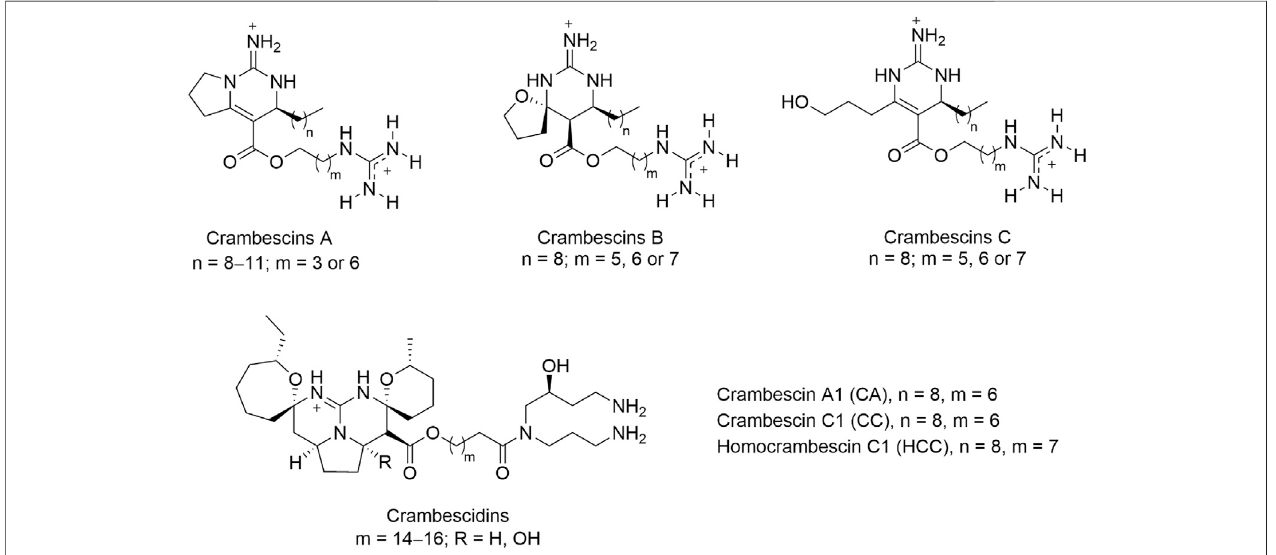
FIGURE 1 | General chemical structures of guanidine alkaloids from the marine sponge crambe crambe, crambescins (A – C) and crambescidins, and compounds studied in this work, CA, CC, and HCC.